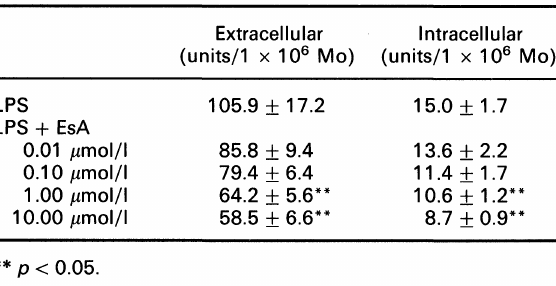
Table 1. Effects of EsA on extracellular and cell associated TNF production by